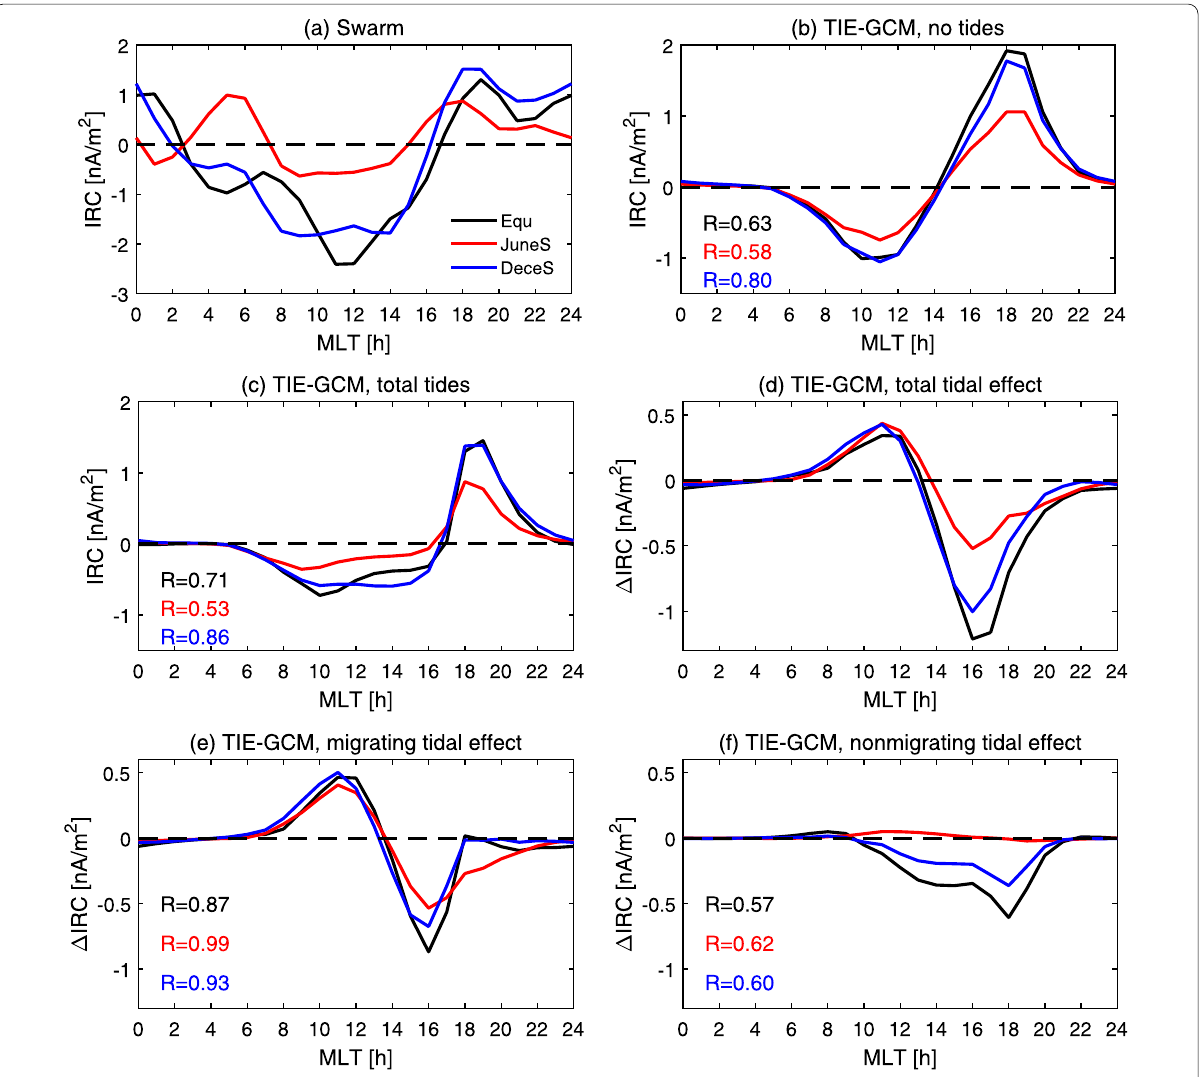
Fig. 2 Diurnal distribution of a observed IRC averaged over 1° MLat, b simulated IRC without tides input, c simulated IRC with tides imposed ± (including migrating and nonmigrating tidal), d tidal ΔIRC, e migrating tidal ΔIRC, and f nonmigrating tidal ΔIRC. Black, red, and blue curves denote the equinox, JS, and DS, respectively. The MLT resolution was 1 h, and positive values represent outward currents. The model IRC are averaged over 5° MLat. The linear correlation coefficients in b and c are calculated relative to the Swarm observations, and the correlation coefficients in e ± and f are calculated relative to the total tides